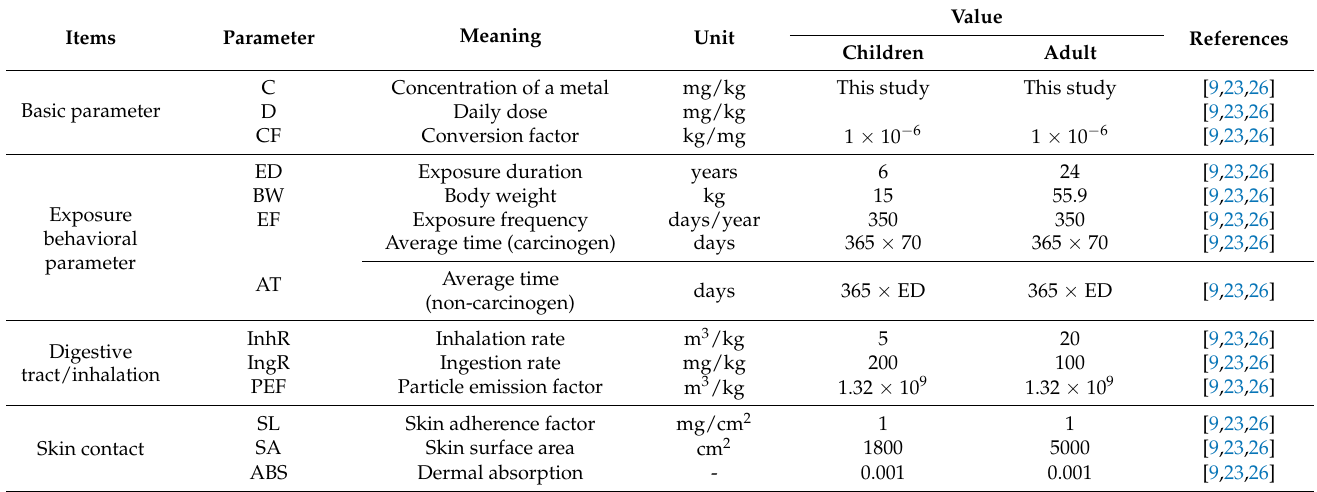
Table 2. Exposure factors for dose